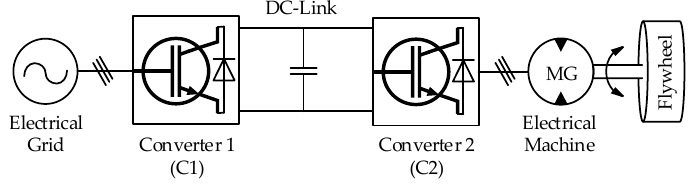
Figure 4. Back-to-back bidirectional power converters.